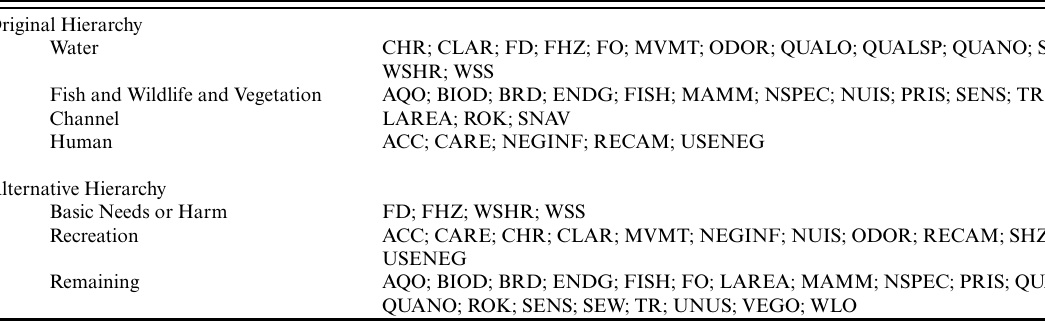
Table 2 . Original and recategorized attribute categories.